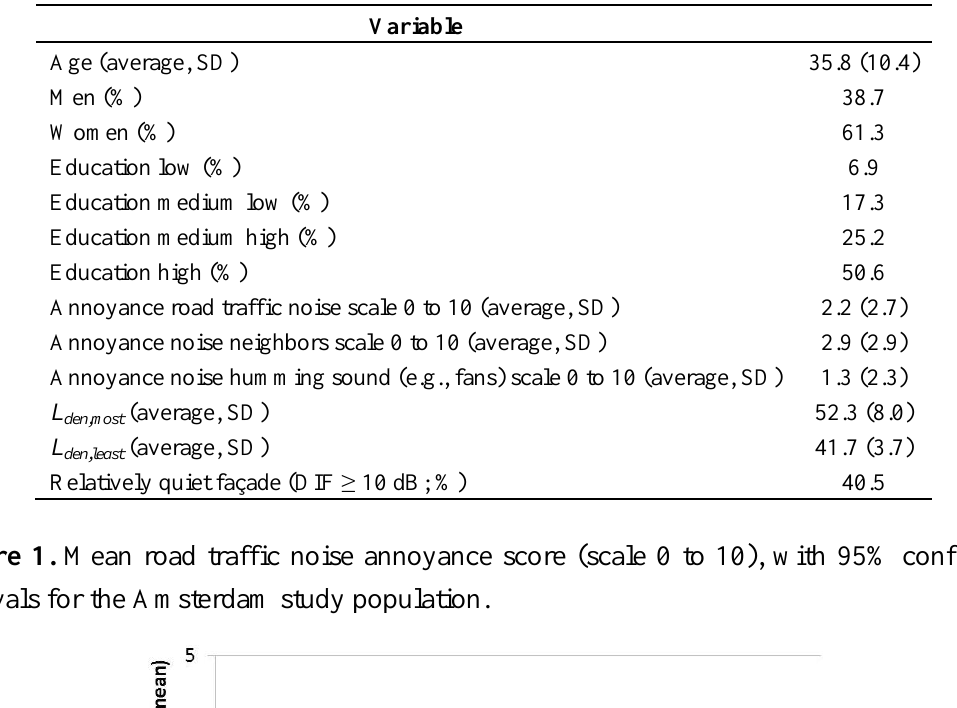
Table 1. Characteristics of the Amsterdam study population.